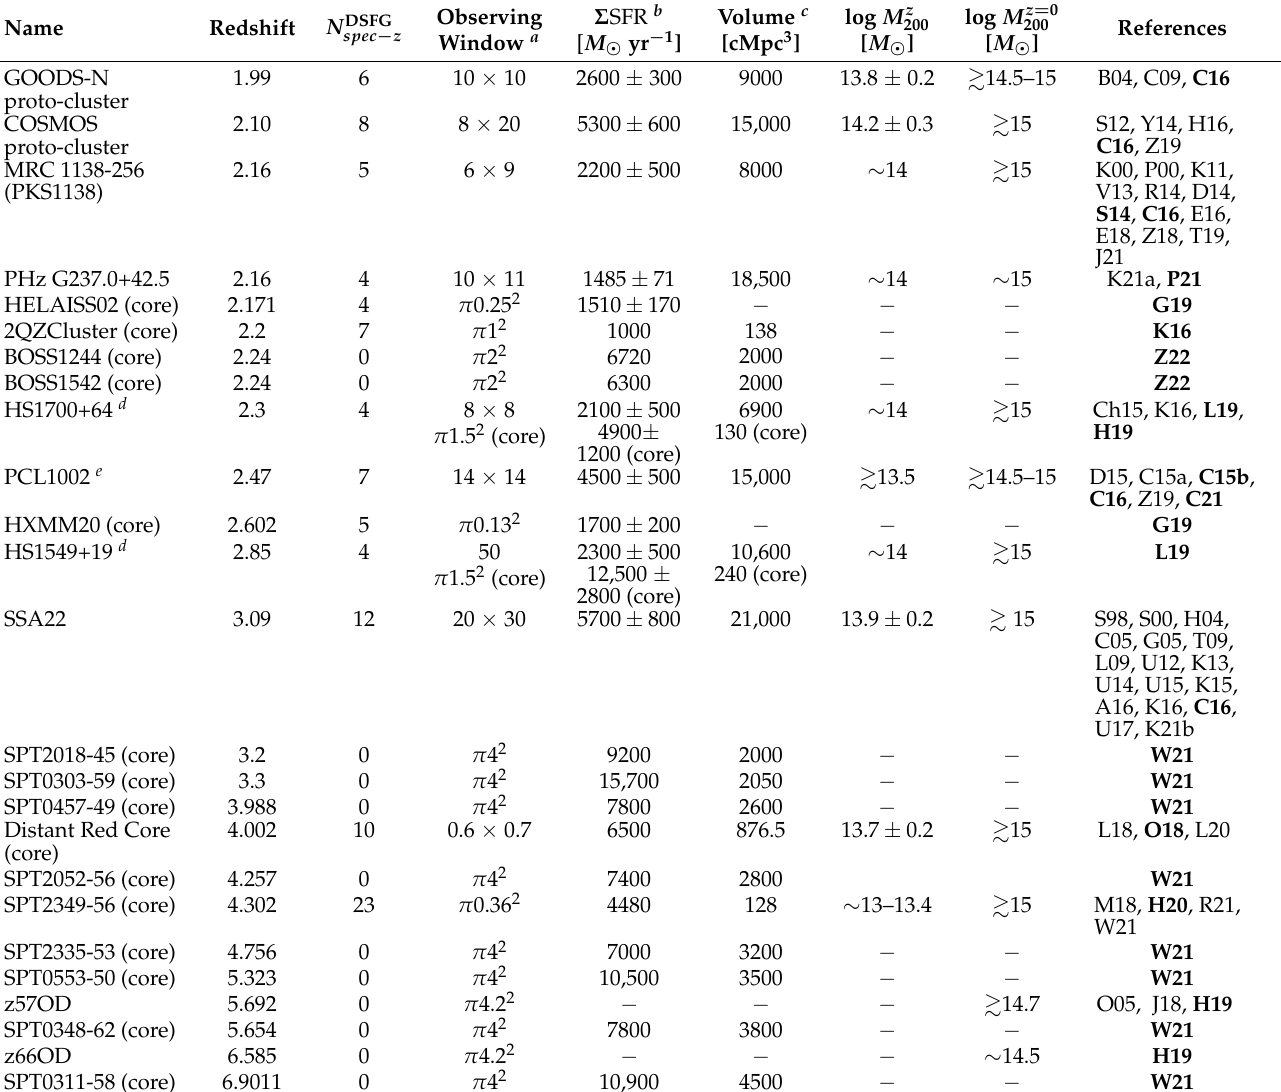
Table 3. An Incomplete List of Proto-clusters in the Literature with DSFG